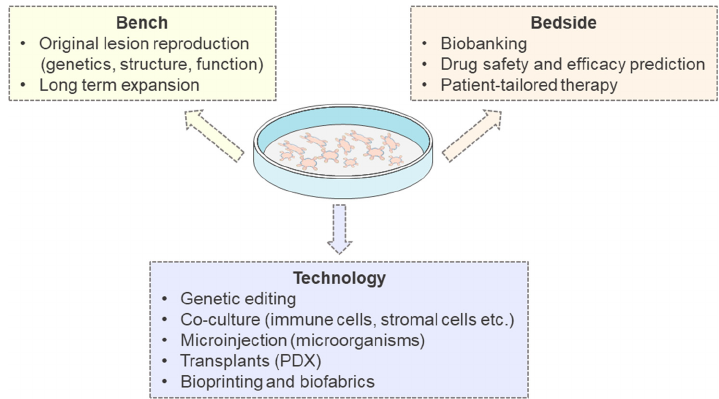
Figure 3. Translational importance of Patients Derived Tumor Organoids (PDTOs). PDTOs are useful at the bench (yellow box; they reproduce genetics, structure and function of the original tumor and they can be expanded long-term), at the bedside (orange box; they can be cryopreserved and thaw, they are a predictive tool in drug testing and can be used for personalized medicine). Moreover, organoid technology can be integrated (purple box; with gene editing, co-culture, microinjections, xeno-transplants, biomaterials). PDX, Patients Derived